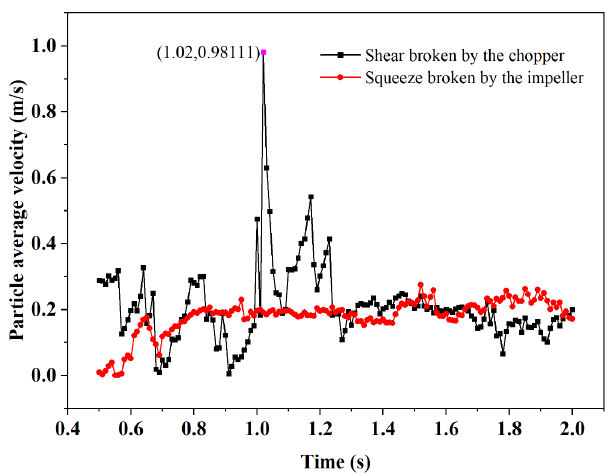
Figure 8. Particle average velocity between 0.5 s and ~2 s.